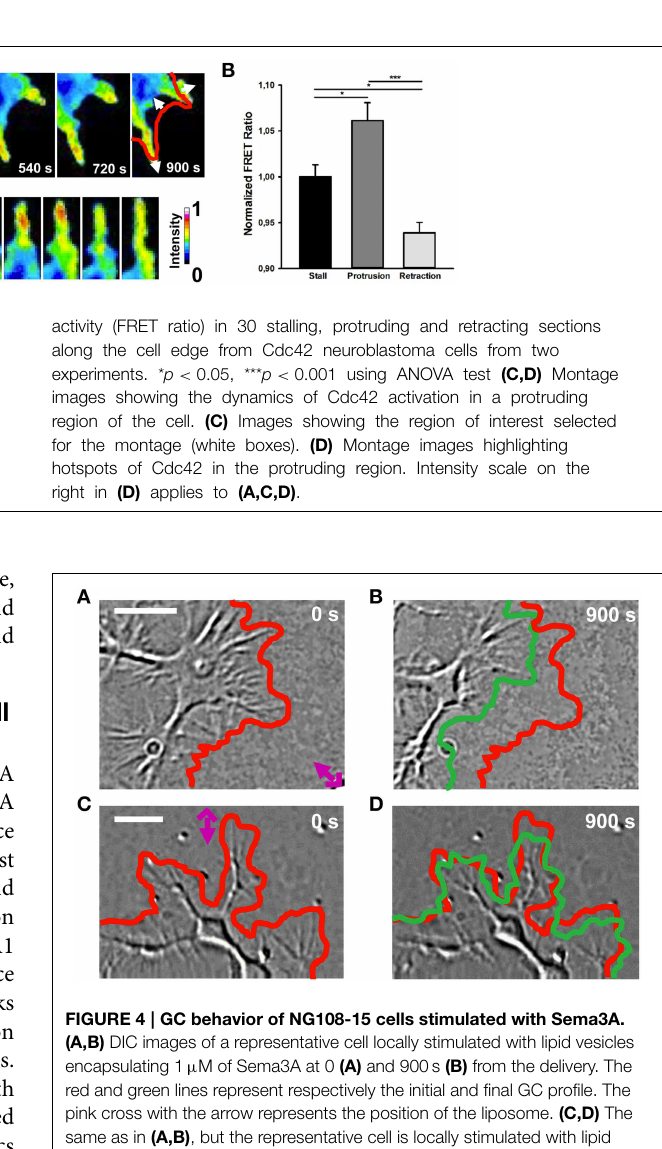
FIGURE 4 | GC behavior of NG108-15 cells stimulated with Sema3A. (A,B) DIC images of a representative cell locally stimulated with lipid vesicles encapsulating 1 µ M of Sema3A at 0 (A) and 900s (B) from the delivery. The red and green lines represent respectively the initial and final GC profile. The pink cross with the arrow represents the position of the liposome. (C,D) The same as in (A,B) , but the representative cell is locally stimulated with lipid vesicles encapsulating 1 µ M of BSA. Frames were taken every second for 15min in both cases. Contrast and brightness enhancement were applied to all images, followed by bandpass filtering of the spatial frequencies to enhance the edge contrast.